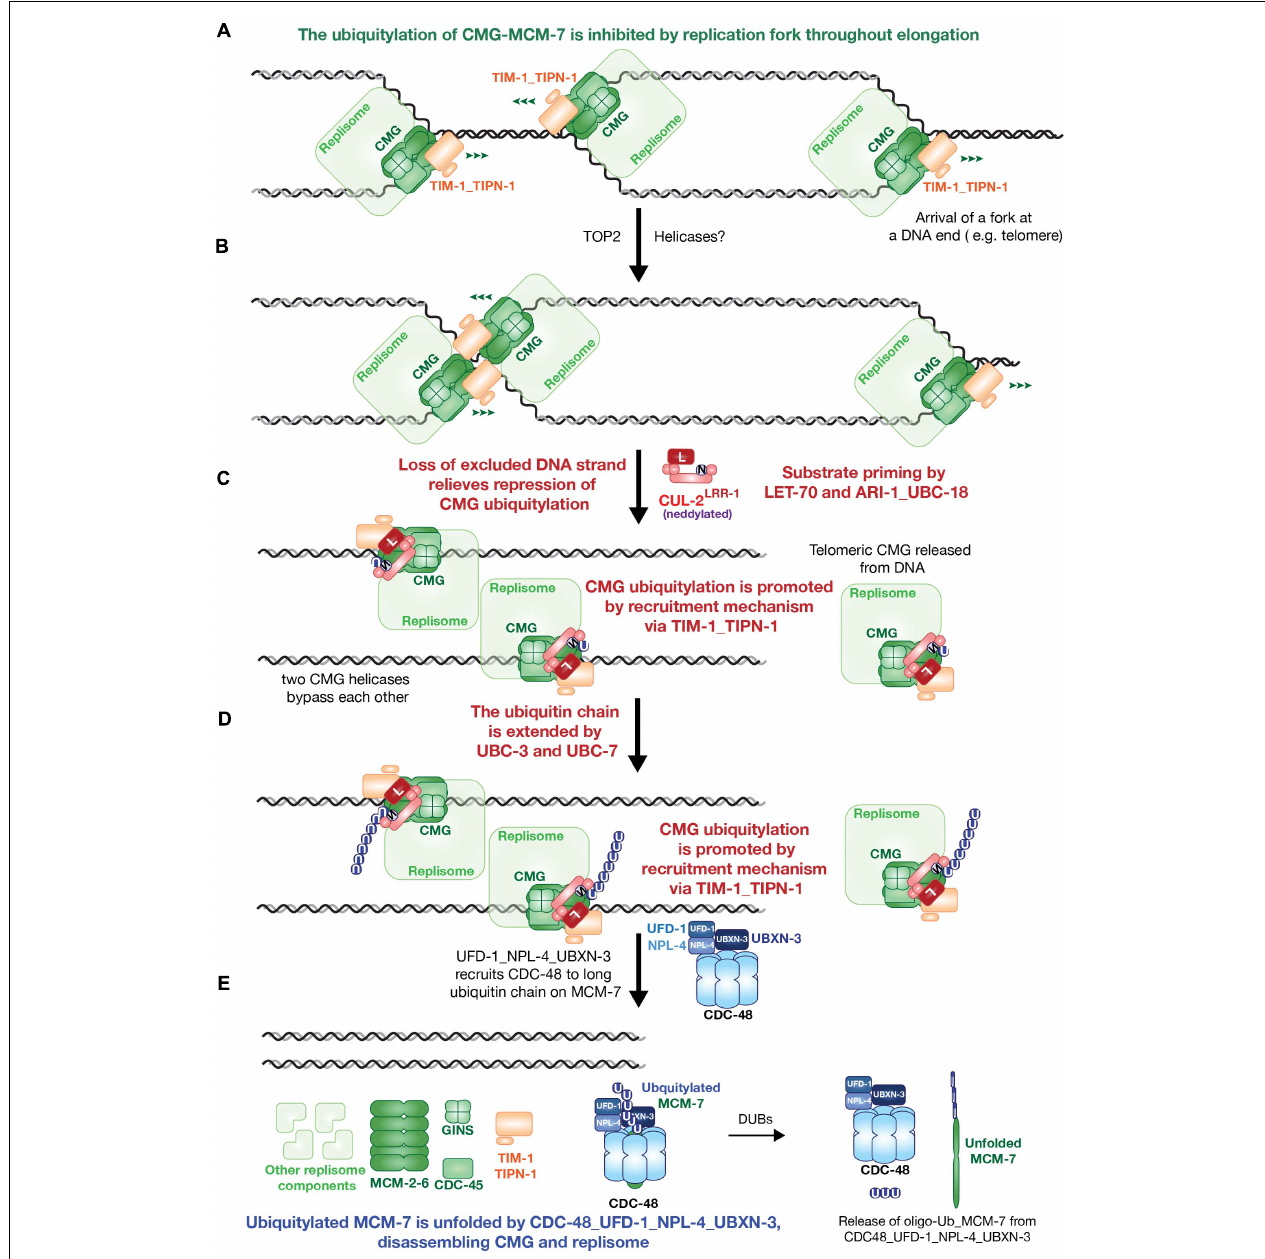
FIGURE 2 | A possible model of Caenorhabditis elegans replisome disassembly during DNA replication termination. (A) Replication fork structure blocks CMG ubiquitylation during replication elongation. (B) Fork convergence is supported by type II topoisomerases or other uncovered pathways (C) CMG ubiquitylation starts with substrate priming step via LET-70 or ARI-1_UBC-18 with neddylated CUL-2 LRR − 1 when the repression from fork DNA is eliminated. (D) E2s UBC-3 or UBC-7 work with neddylated CUL-2 LRR − 1 to extend ubiquitin chain on MCM-7. Both of substrate priming and ubiquitin chain extension are stimulated by recruitment of CUL-2 LRR − 1 via TIM-1_TIPN-1. (E) UFD-1_NPL-4_UBXN-3 recruits CDC-48 to ubiquitylated CMG, as a result, MCM-7 is unfolded and replisome is